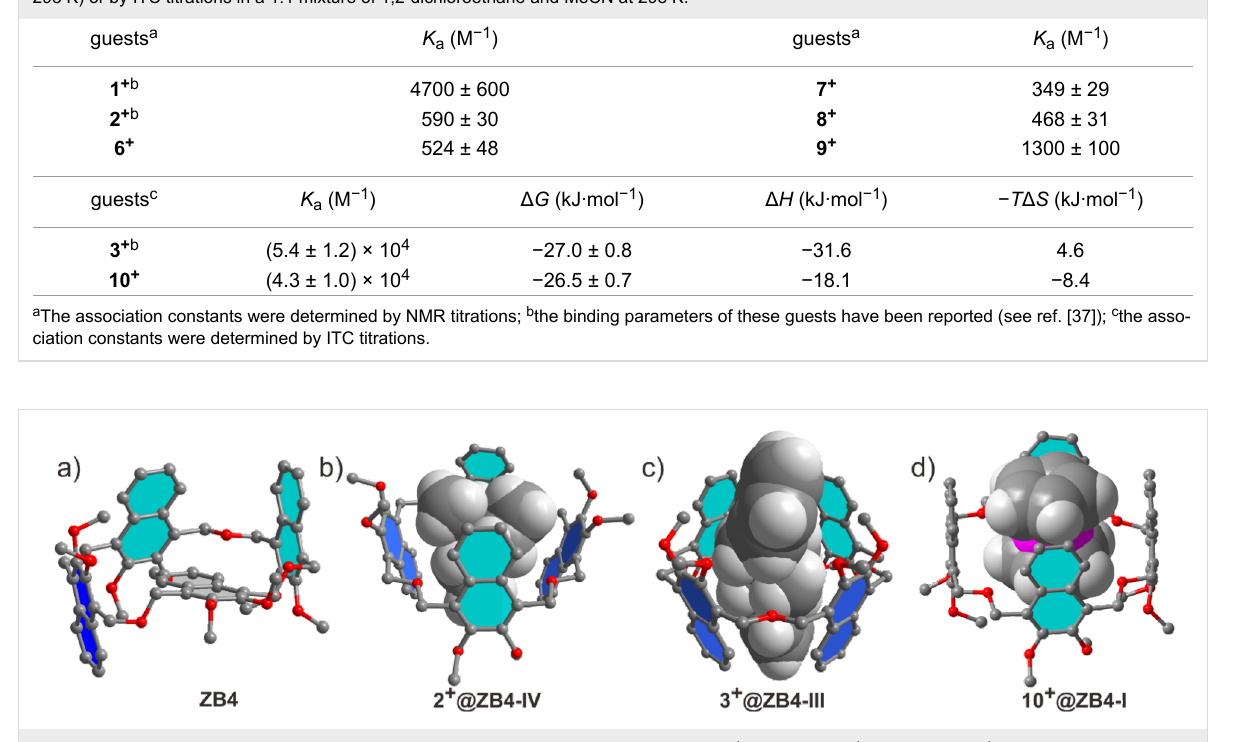
Figure 1: X-ray single crystal structure of ZB4 and the host–guest complexes. a) ZB4 , b) 2 + @ ZB4-IV, c) 3 + @ ZB4-IV, d) 10 + @ ZB4-I . Hydrogen atoms of the host are removed and butyl groups are shortened to methyl groups for viewing clarity. The X-ray single crystal structures of 2 + @ ZB4-IV (b) and 3 + @ ZB4-III (c) have been reported previously (see